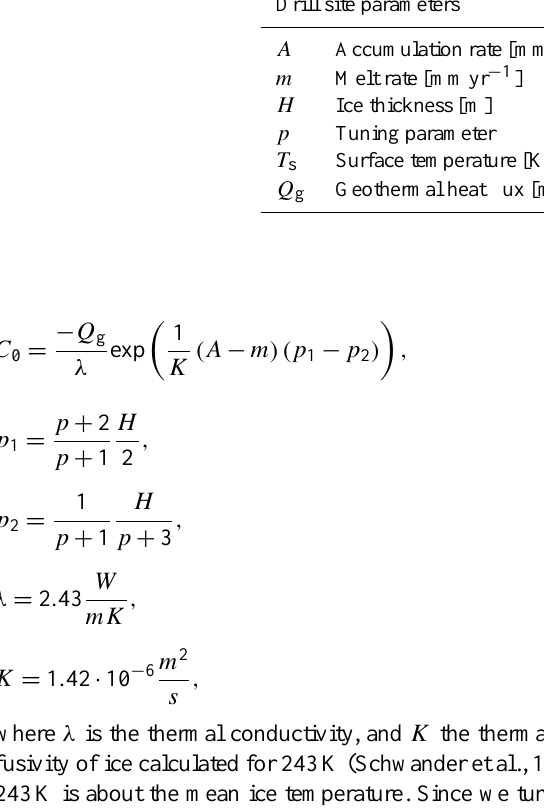
Table 1. Drill site parameters for the different model experiments. The Vostok ice thickness (ice equivalent) is given by Salamatin et al. (1998). The other Vostok parameters are derived from the calibration procedure. For the EDC parameters the accumulation rate (tem- poral mean), the melt rate and the ice thickness (ice equivalent, temporal mean) of Parrenin et al. (2007a) are used. The EDC surface temperature (temporal mean) is from Jouzel et al. (2007). The EDC tuning parameter and the geothermal heat flux are derived from the calibration procedure. The oldest ice core parameters are artificial and set such that the age and temperature requirements (1.5Myr 100m above ground, bottom temperature below pressure melting point) are fulfilled. Drill site parameters